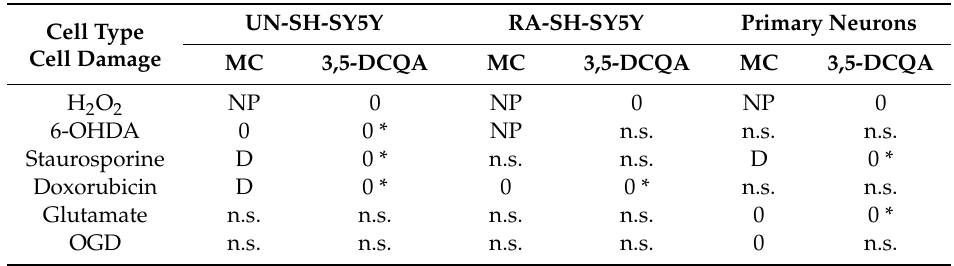
Table 3. Summary of MC and 3,5-DCQA e ff ects in SH-SY5Y cells and in primary neurons in various models of neuronal cell